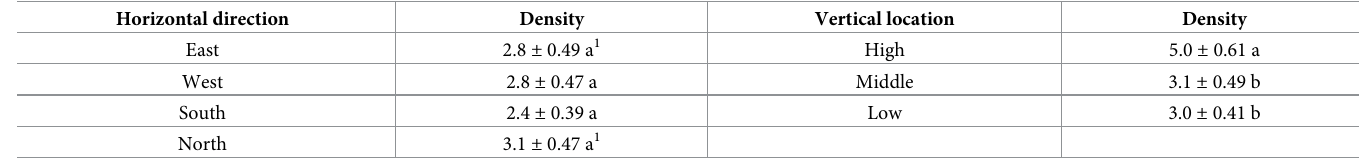
Table 1. Densities of R . shantungensis egg masses (mean ± SE) according to horizontal and vertical locations of a whole branch within a persimmon tree.